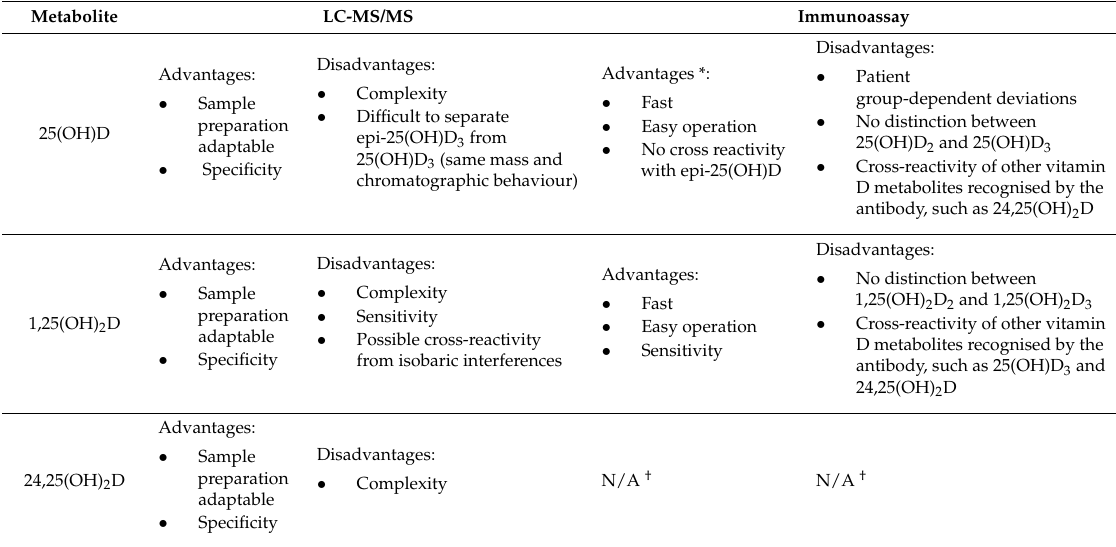
Table 1. Advantages and disadvantages of current LC-MS/MS methods and immunoassays for vitamin D metabolism